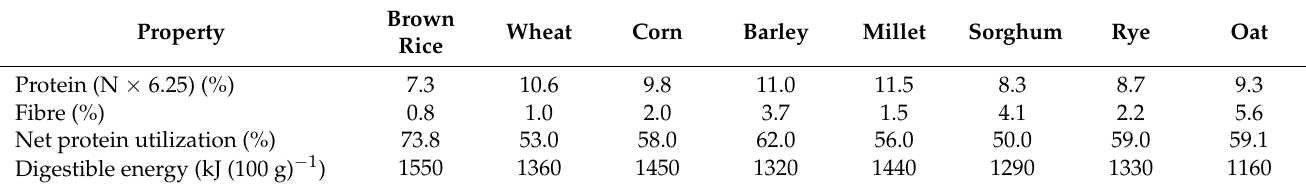
Table 4. Protein and fibre content of cereal